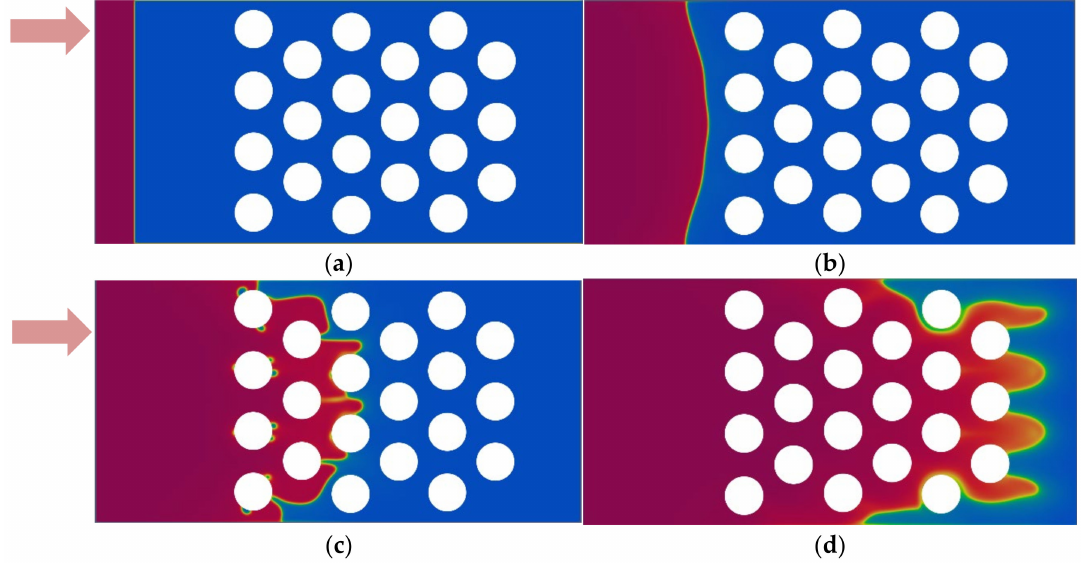
Figure 9. CO 2 penetration pattern with a parabolical profile and front initially at 75 LU from pore network. Same color scheme is used, as in Figure 6. ( a ) 0 ts. ( b ) 3300 ts. ( c ) 6100 ts. ( d ) 9000